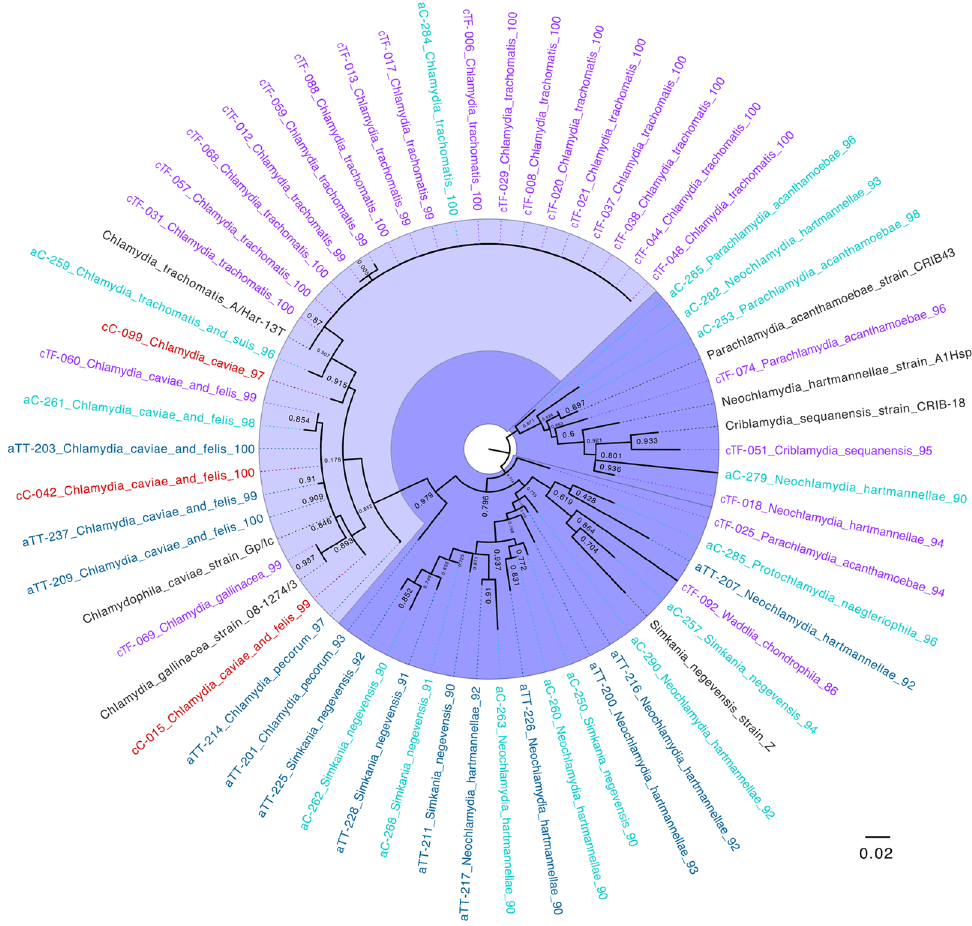
Figure 3. The maximum likelihood phylogenetic tree derived from the partial 16 S rRNA sequences detected in this study. Household IDs of samples are shown on left. Children cases are marked in purple (cTF), children controls (cC) in red, adults cases in dark blue (aTT), adults controls in cyan (aC), and the reference strains corresponding to species for which there was at least one best BLAST hit in black. The best BLAST hit identity (%) for each sample stands on the right side of the lables.